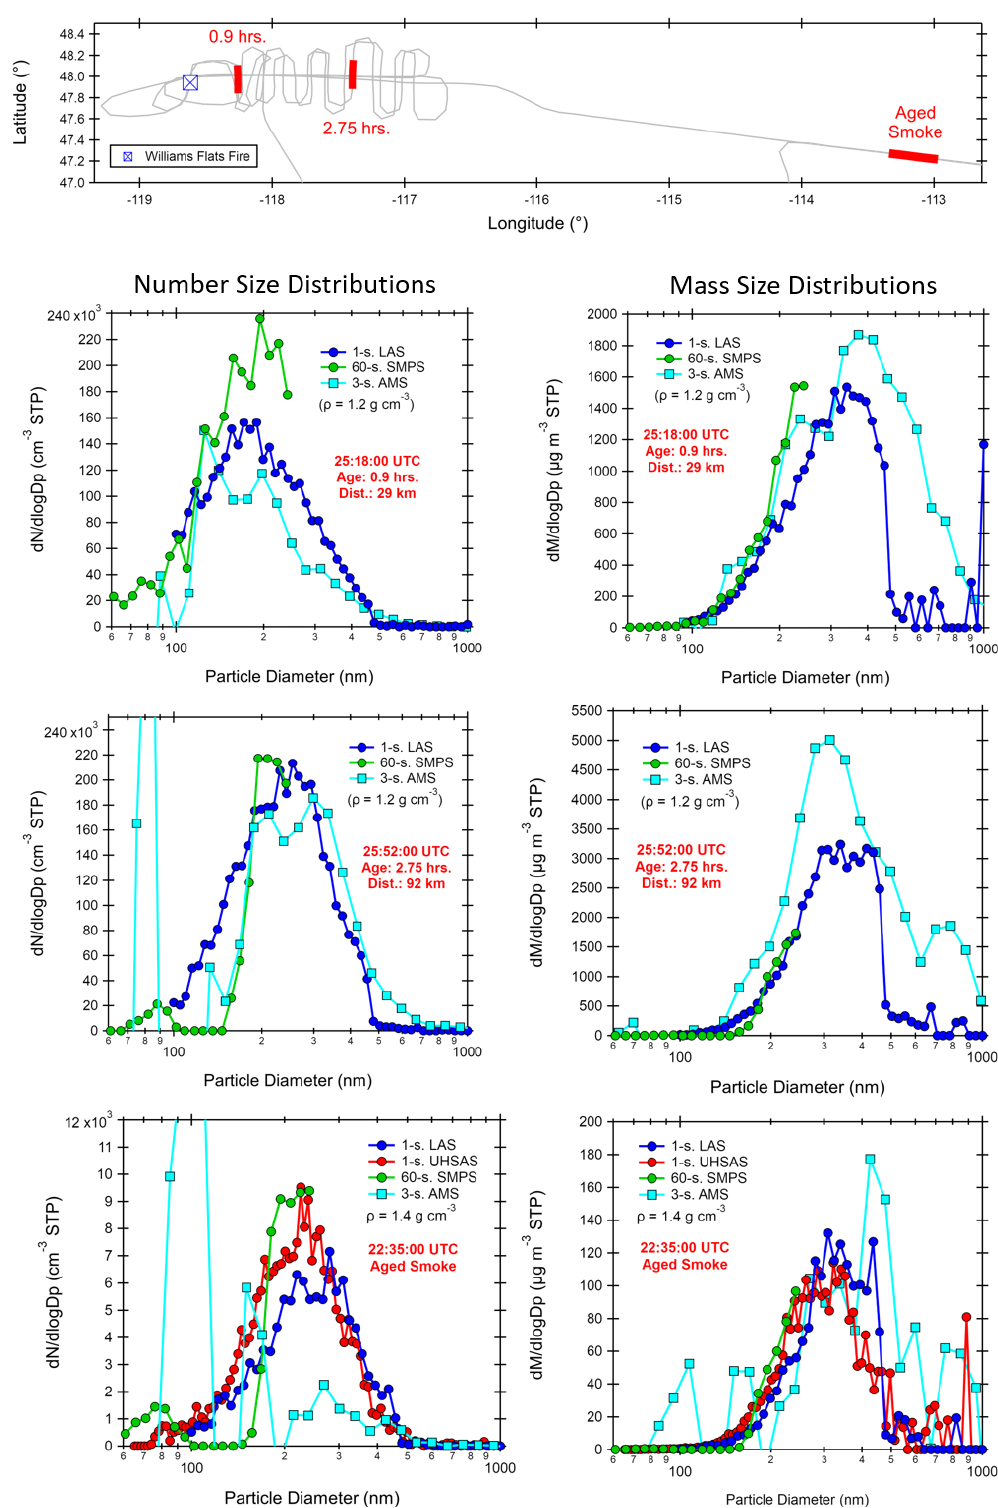
Figure 11. Comparison of the size distributions measured by the AMS, LAS, UHSAS, and SMPS at three downwind distances from the Williams Flats Fire in the state of Washington, USA, during the 7 August 2019 FIREX-AQ flight, including smoke sampled much farther afield. Mass distributions are computed for the LAS, UHSAS, and SMPS, assuming spherical particles and using the aerosol density estimated from the mass spectrometer, while the calculation is applied in reverse to compute AMS number distributions. This density is also used to convert the AMS vacuum aerodynamic diameters to spherical-equivalent diameters. Reported sizes are for dry particles (RH <